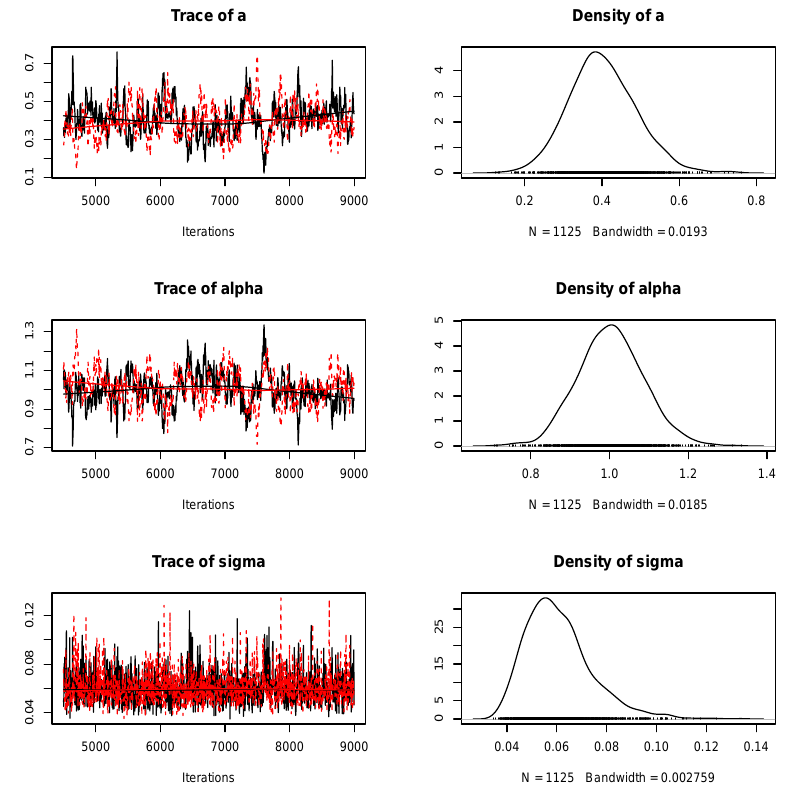
Figure 3. Trace and estimated posterior densities of a , α and σ